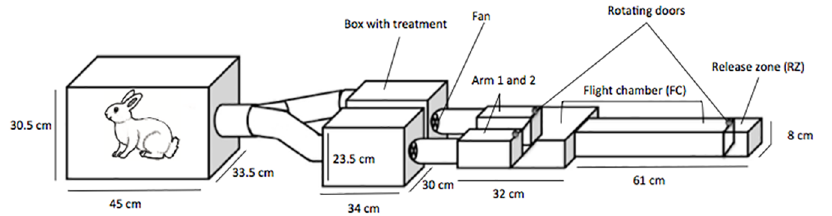
Fig 1. Experimental set-up. Dual-choice olfactometer(right side) connectedto the treatment boxes (middle) and the wide chamber(left